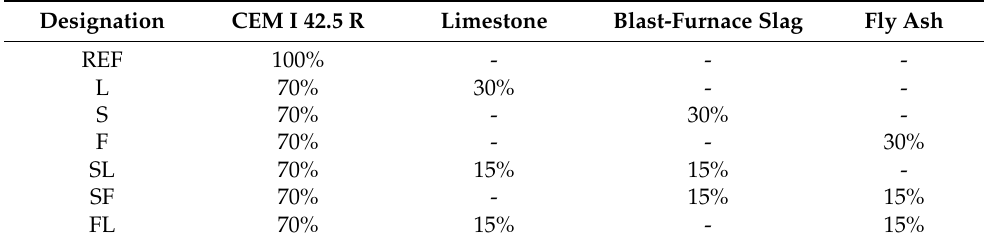
Table 1. Designation of the mortars studied and percentage (in weight) of CEM I and additions [42].